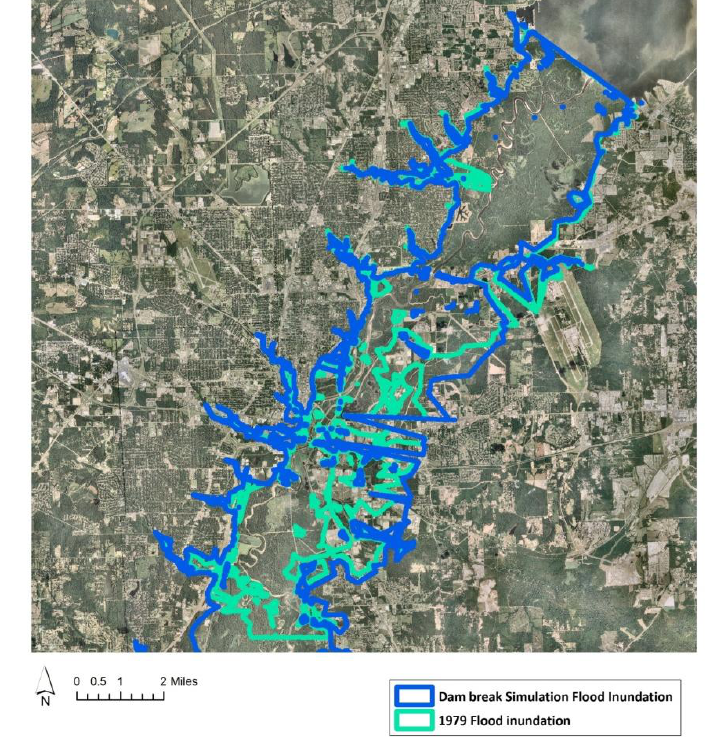
Figure 12. Comparison of inundation patterns of dam break simulation and 1979 flood